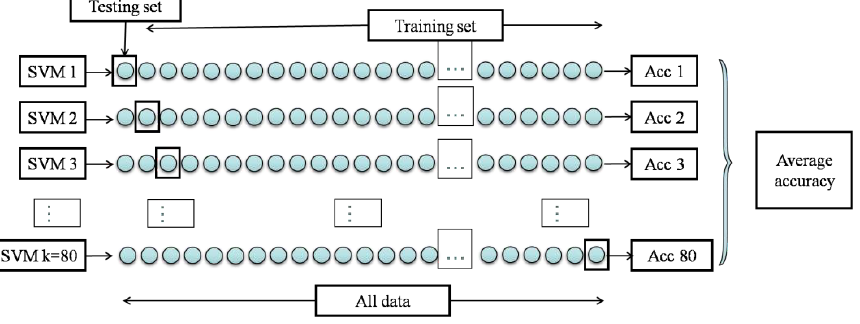
Figure 11. Diagram of leave-one-out cross-validation (k-fold cross-validation with k = 80).